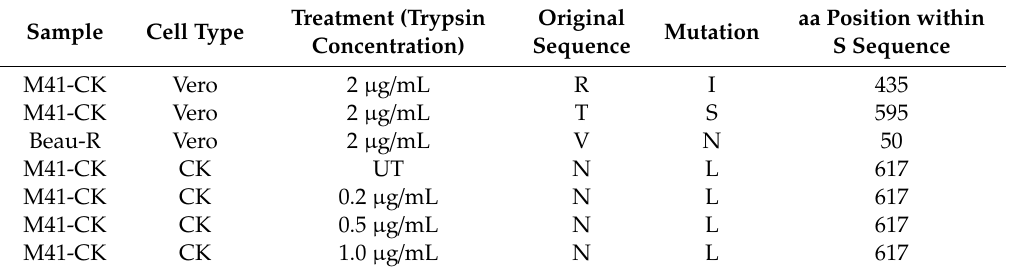
Table 1. Mutations in the M41-CK and Beau-R S gene following passaging in the presence of trypsin. aa Position within Treatment (Trypsin Original Mutation Sample Cell Type S Sequence Concentration) Sequence M41-CK Vero 2 µ g / mL R I 435 M41-CK Vero 2 µ g / mL T S 595 50 617 M41-CK 617